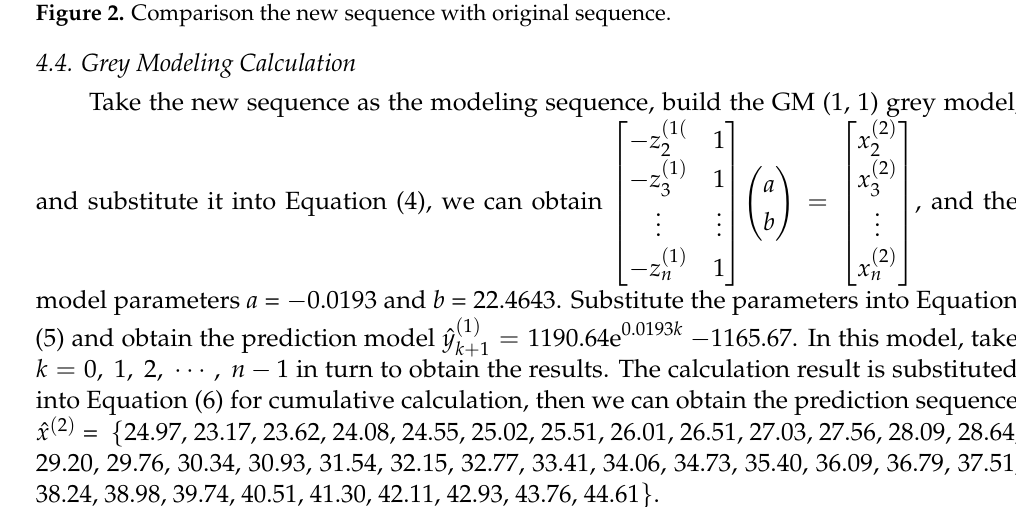
Figure 2. Comparison the new sequence with original sequence.